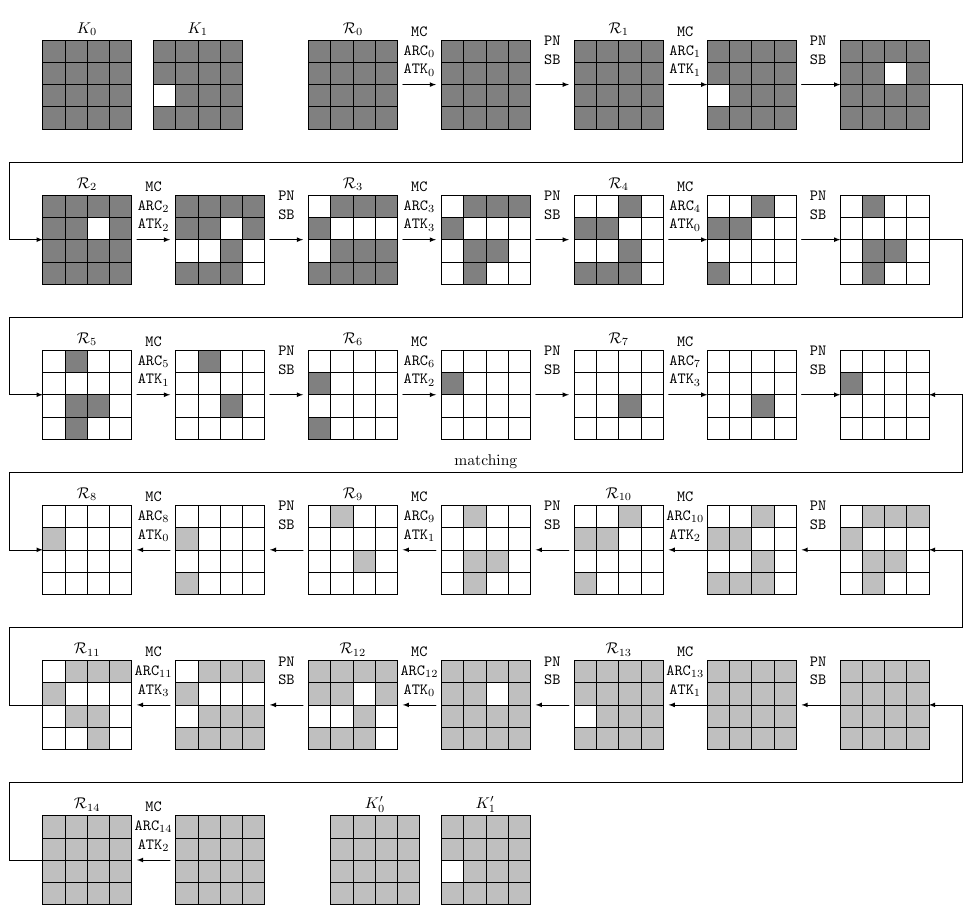
Figure 6: A 15-round partial matching meet-in-the-middle for CRAFT